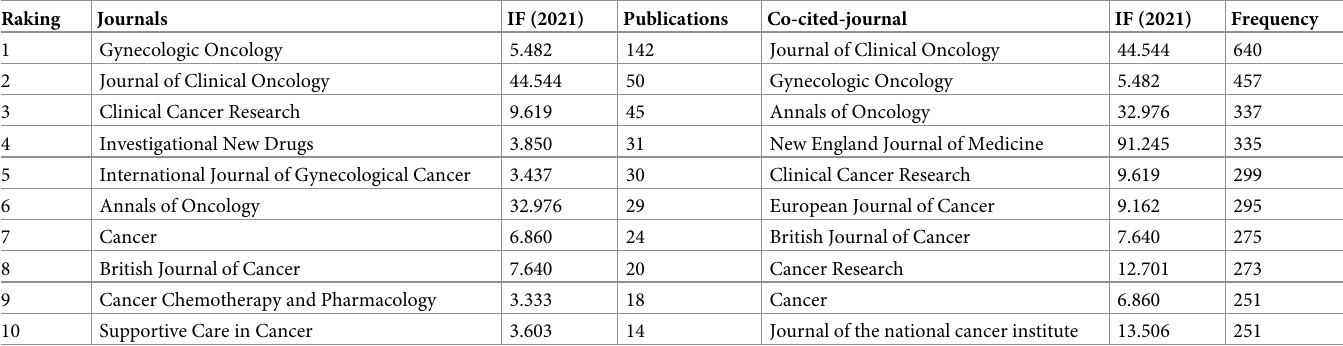
Table 3. Top 10 most productive journals and co-cited